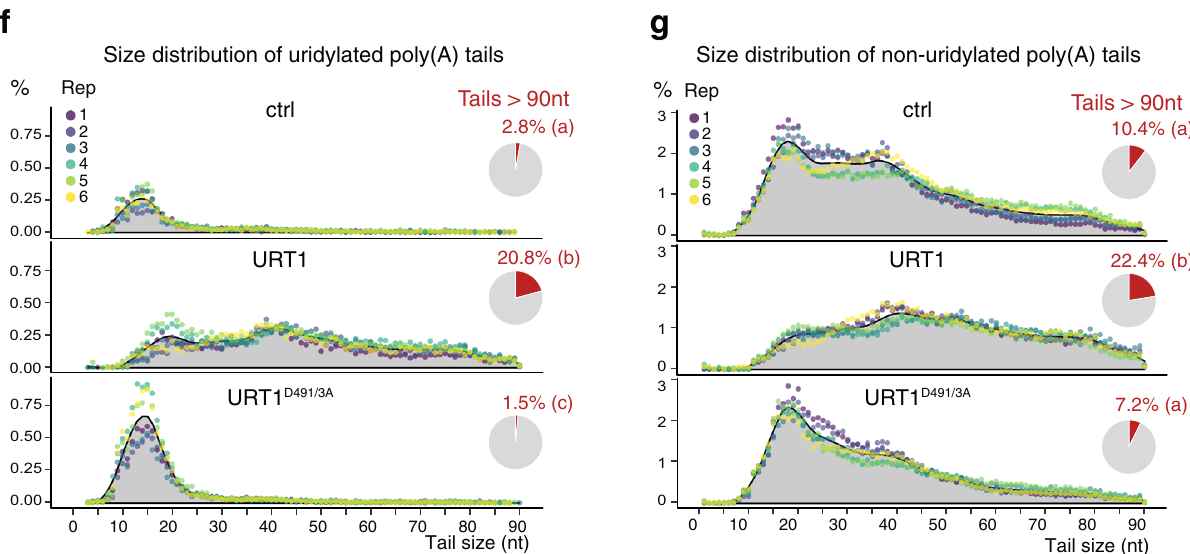
Fig. 3 Ectopic expression of URT1 remodels poly(A) tail pro fi les. a Domain organization and mutations of different URT1-myc versions transiently expressed in N. benthamiana leaf patches. Legend as in Fig. 1a. b Western blot analysis of URT1-myc expression. c Representative N. benthamiana leaf under UV light to detect the expression of the GFP reporter co-expressed with the different URT1-myc versions (top). Quanti fi cation of GFP fl uorescence of the different patches relative to control (ctrl) for 11 independent replicates (bottom). d Northern blot analysis of the steady-state level of GFP mRNAs. The arrows indicate unspliced and mature forms of GFP mRNAs. e Uridylation percentage of GFP reporter mRNAs for six biological replicates. f , g Distribution pro fi les of GFP mRNA poly(A) tail sizes. The percentages of sequences were calculated for six biological replicates for uridylated ( f ) and homopolymeric poly(A) tails (non-uridylated) ( g ) tails from 1 to 90 nucleotides. The percentages were calculated using the total number of sequences with tails from 1 to 90 nucleotides. Individual points are color-coded for each replicate and the average of all replicates is indicated as a gray area. The pie charts represent the average proportion of tails longer than 90 nucleotides. Letters in ( c , e – g ) represent signi fi cant statistical p value (two-tailed Wilcoxon rank-sum test, n = 11 ( c ) and n = 6 ( e – g )). Exact p values are indicated in Supplementary Data 3e. The source data are available in Supplementary Data 3, at [https://www.ncbi. nlm.nih.gov/geo/query/acc.cgi?acc = GSE148409] and at